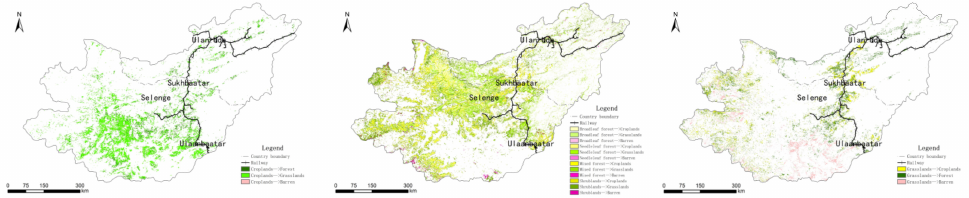
Figure 15. Cultivated land, forest land, and grassland conversion map of the Selenga River basin in